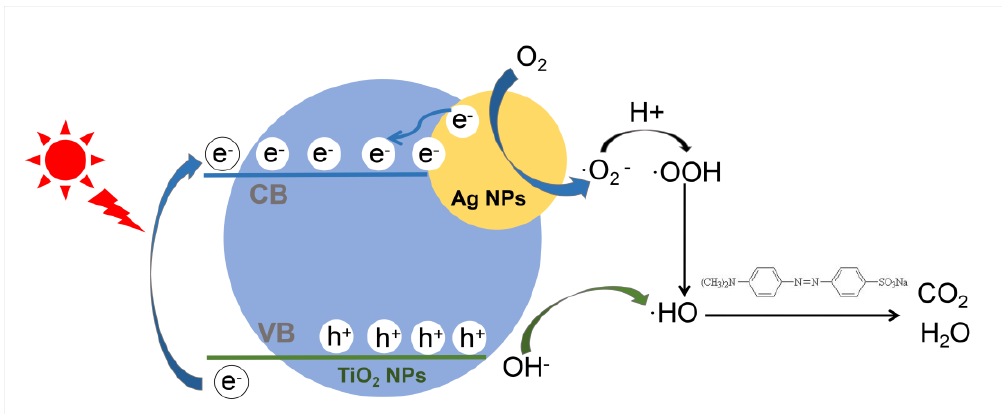
Figure S4: Mineralization rates of MO by the samples under UV and Visible light irradiation. Samples 1–4 denote pure TiO 2 NPs, Ag@TiO 2 NPs-